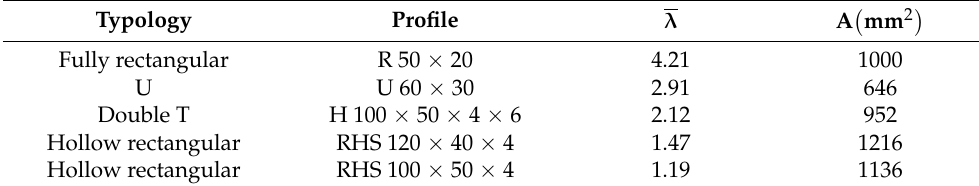
Table 3. Different profiles and normalized slenderness of the diagonals.